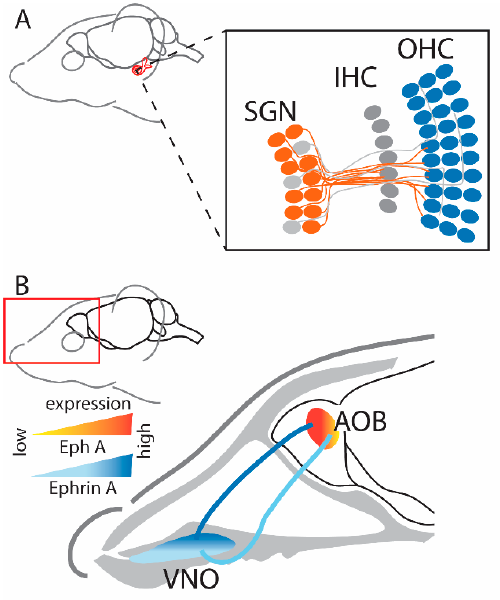
Figure 3. ( A ) Representation of the projections in the auditory system (cochlea) where type I SGNs expressing EphA4 project to OHCs that highly express ephrin-A5 ligands [55]. Note that their gradient is not well defined and therefore is not depicted here. Figure created using data from [55]. ( B ) Representation of the projections in the vomeronasal system where projections from VNO with EphA6 expression target regions with a similar expression of ephrin-A5 in the AOB [63], therefore unlike other sensory systems, projections in the vomeronasal system are guided by attraction. Figure created using data from [63] (SGN—spiral ganglion neurons; IHC—inner hair cells; OHC—outer hair cells; VNO—vomeronasal organ; AOB—accessory olfactory bulb).